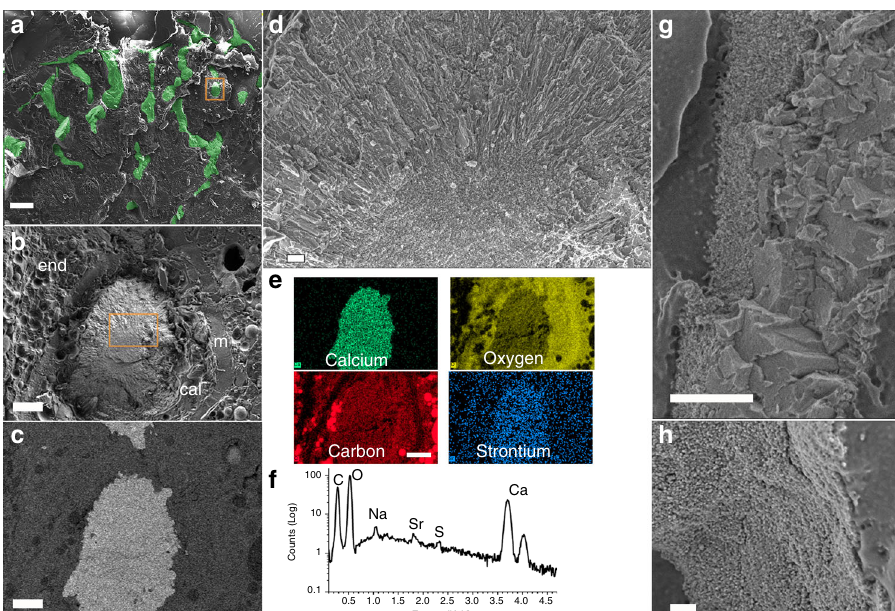
Fig. 3 Cryo-SEM images of minerals at the primary polyp. a Low-magni fi cation SE image of a primary polyp showing the part of the primary mineralized septa radially arrayed in hexacoral pattern (digitally colored in green). b High-resolution SE image of the mineral delimited by the orange box in a showing the mineral deposit surrounded by the calicoblastic layer (cal), mesoglea (m), and endoderm (end). c The corresponding BSE image of b . d High-resolution SE image of the mineral delimited by the orange box in b , showing the center of calci fi cation with nanogranular structure from which long acicular aragonite rods extend. e Cryo-EDS maps of the mineral deposit in b , showing the distribution of calcium, oxygen, carbon, and strontium in the mineral deposit and in the organic material of the tissue. f Cryo-EDS spectrum of the mineral in b , presented on a logarithmic scale. g Exemplary SE image of a septum comprising two mineral morphologies, a region of nanogranular mineral, and a region of aragonite fi bers. h Higher magni fi cation of the nanogranular mineral of